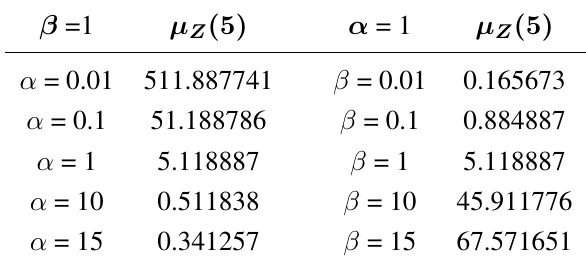
(5) under the Gaussian copula at θ = − 0 . 9 Table 5. Values of µ Z